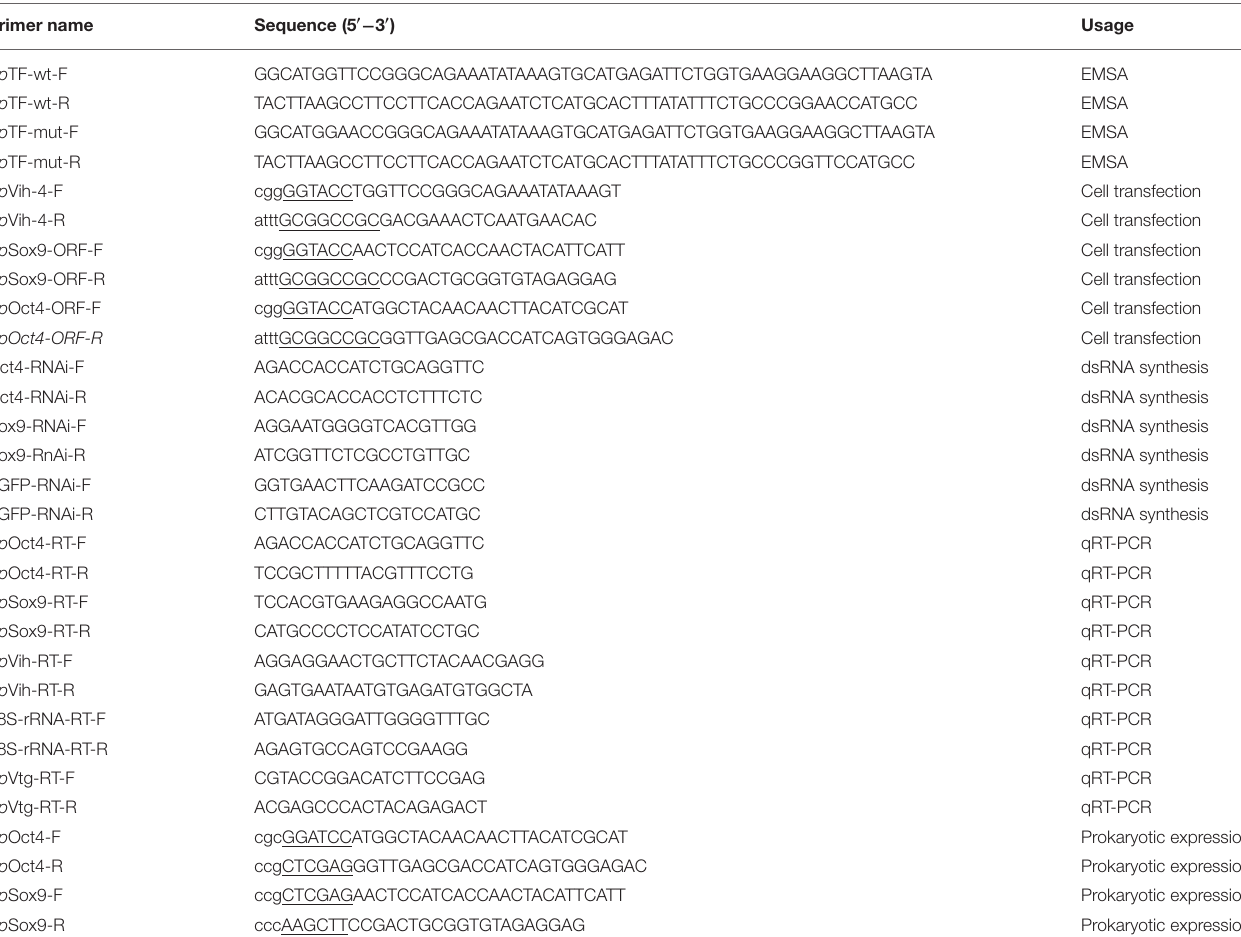
TABLE 1 | Primers used in this